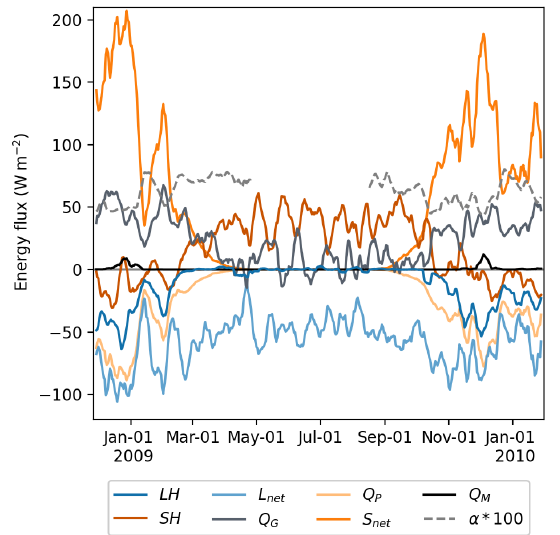
Figure 6. Daily averaged energy balance components during the ob- servational record at Joyce Glacier. A 7d moving average is applied to improve visibility.